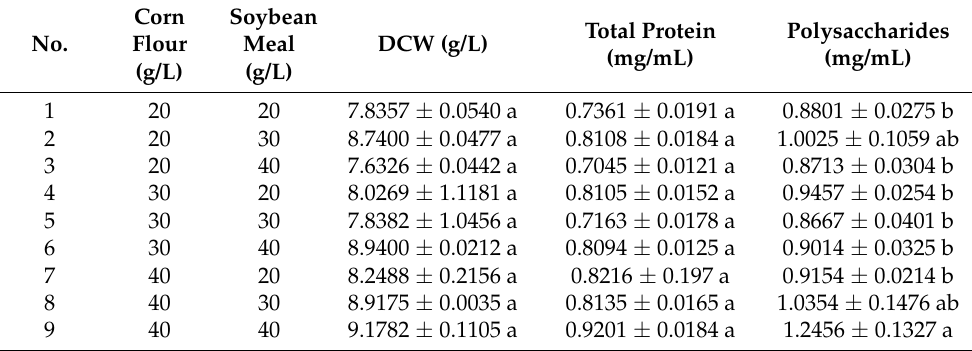
a and b mean indicate significant differences at p < 0.05 by Duncan’s multiple range test.